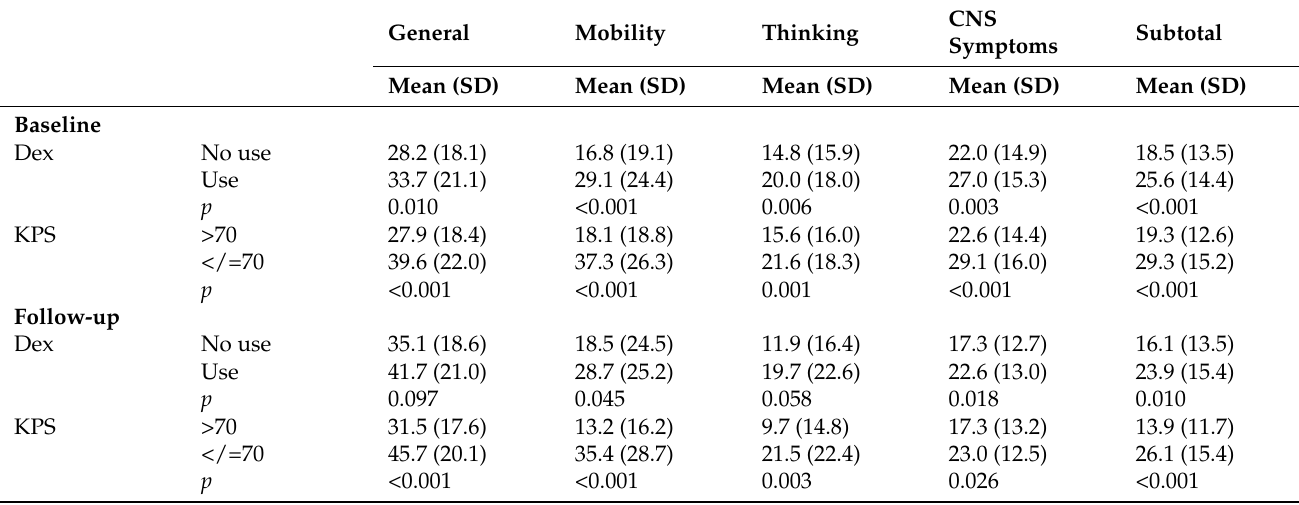
Table 5. Known-group